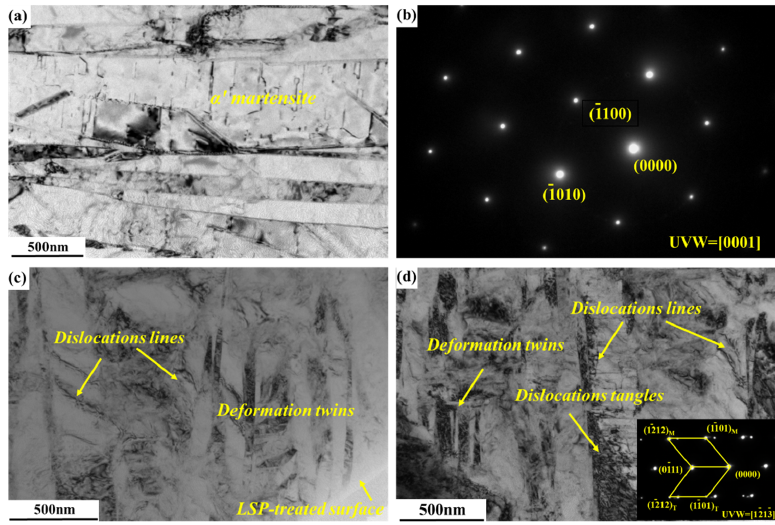
Figure 4. TEM images of SLM Ti64 specimens ( a , b ) before and ( c , d ) after LSP. ( a ) Coarse α’ martensite, ( b ) selective area diffraction pattern (SADP) of hcp α’ phase, ( c ) refined α’ martensite and ( d ) dislocations, deformation twins and the corresponding SADP.